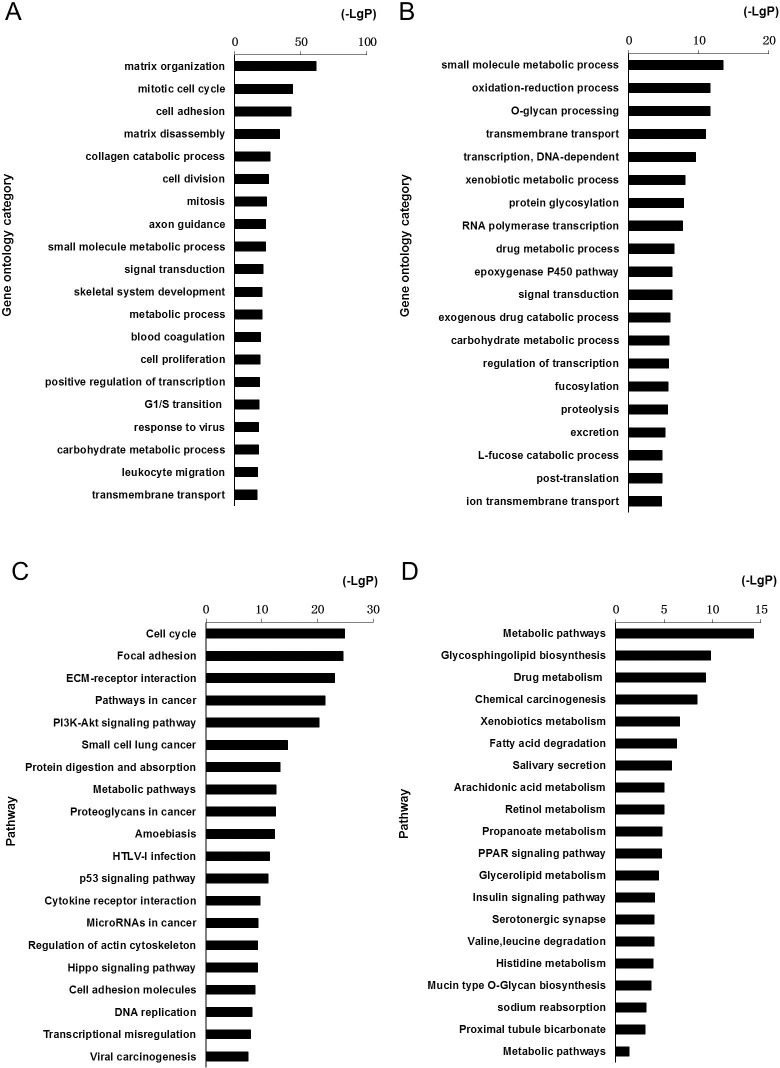
GO and pathway analysis of differentially expressed mRNAs in advanced LSCC.A total of 2381 differentially expressed mRNAs were chosen in GO and pathway analysis. The bar graphs represented the enrichment of these mRNAs. The value of (-LgP) was p value taking the negative logarithm with base 10. The threshold of significance was P value<0.05 and FDR was calculated to correct the P value. (A) Top 20 enriched GO terms among up-regulated mRNAs. (B) Top 20 enriched GO terms among down-regulated mRNAs. (C) Top 20 enriched pathways among up-regulated mRNAs. (D) Top 20 enriched pathways among down-regulated mRNAs.